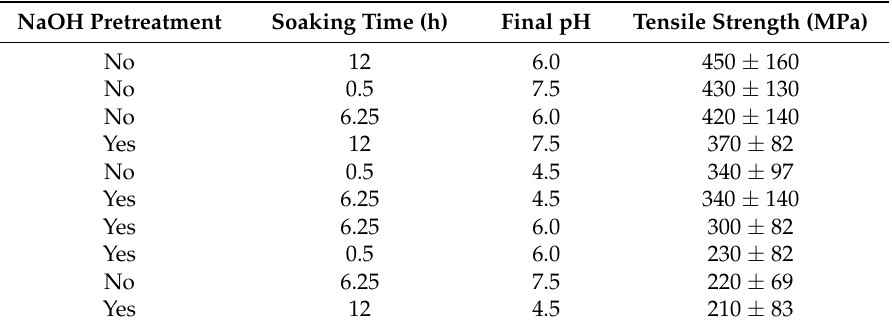
Table 3. Measured response (tensile strength) at different treatment conditions.